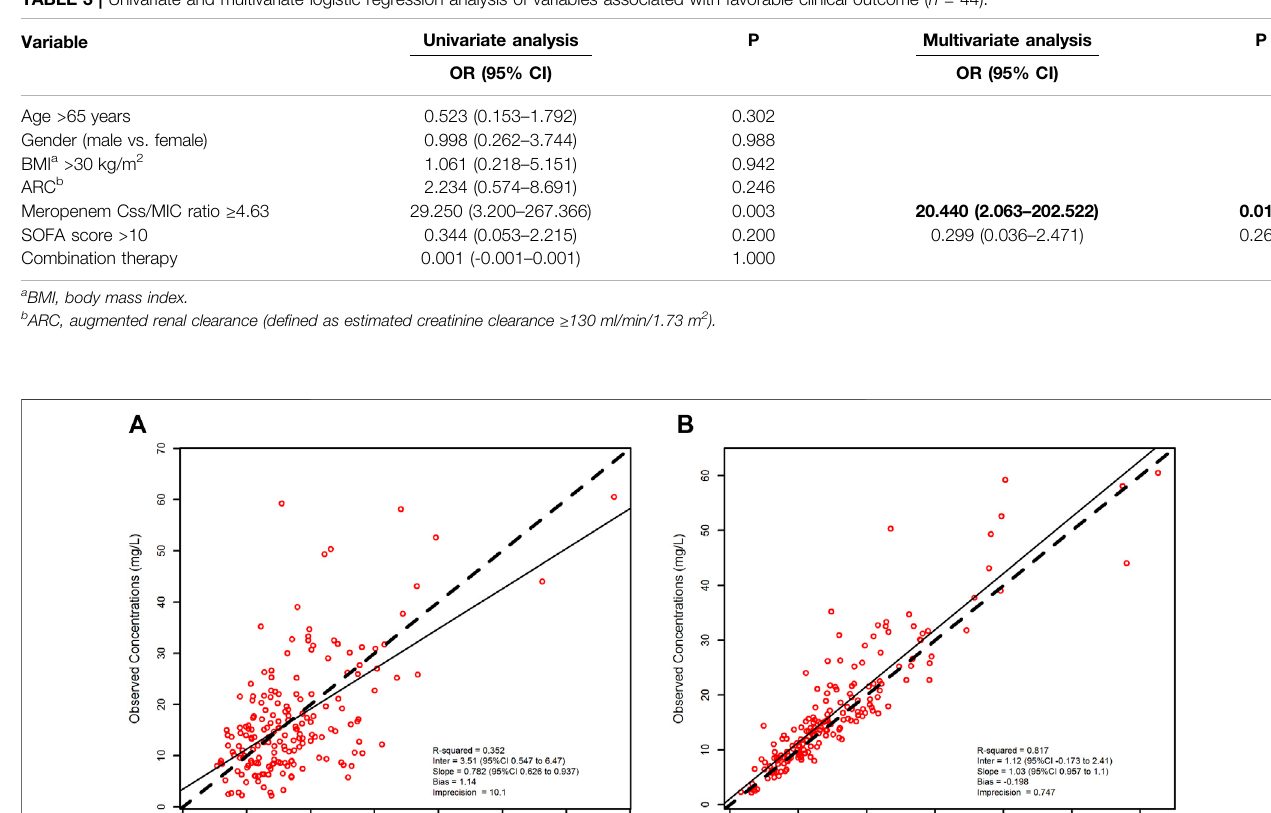
Frontiers in Pharmacology |